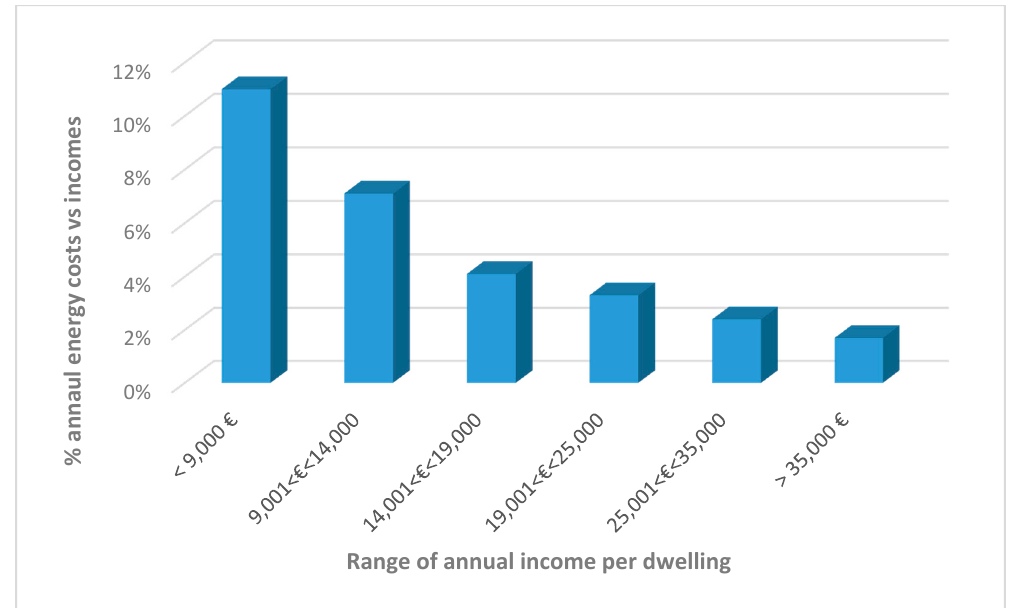
Figure 3. Ratio of annual energy costs and annual income distributed by income level (€/year) of the households.